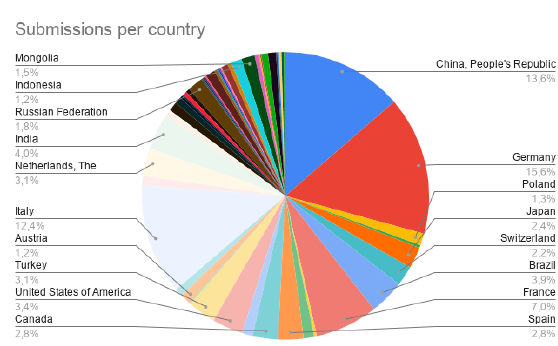
Figure 1. Submitted papers per country.